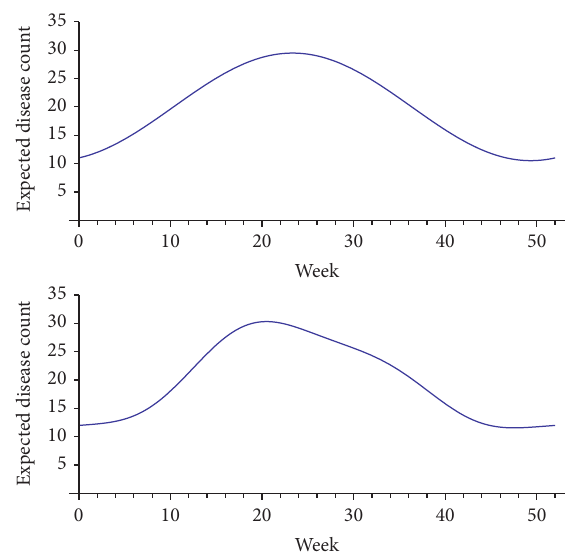
Figure 2: First-order trigonometric model (top) and second-order trigonometricmodel(bottom).Thesecond-ordermodelcanbeused in situations where the disease “lingers” after